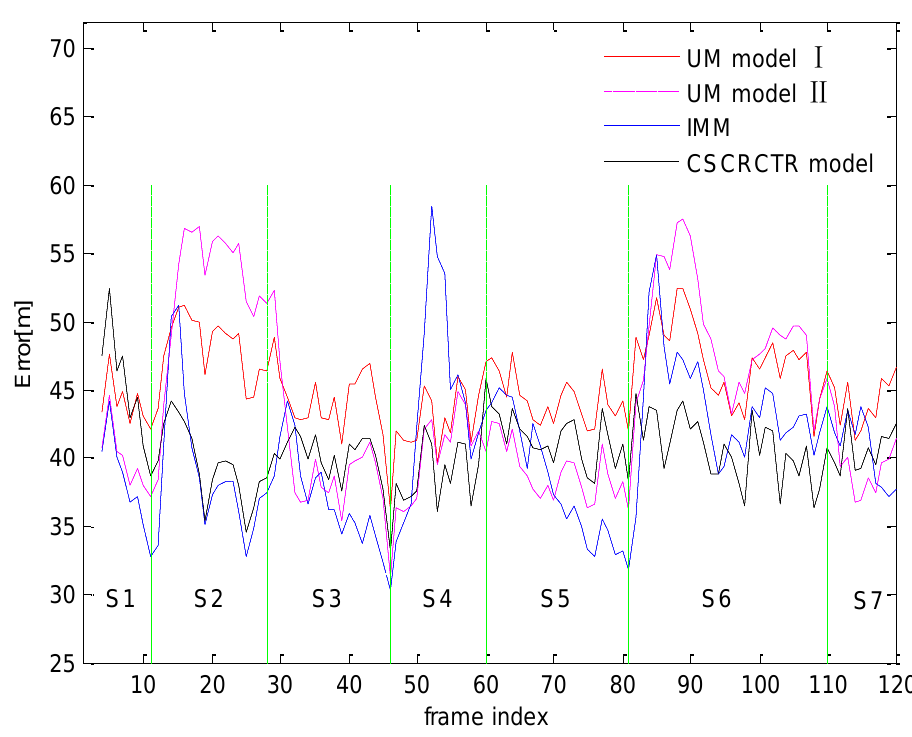
Figure 4. RMS position